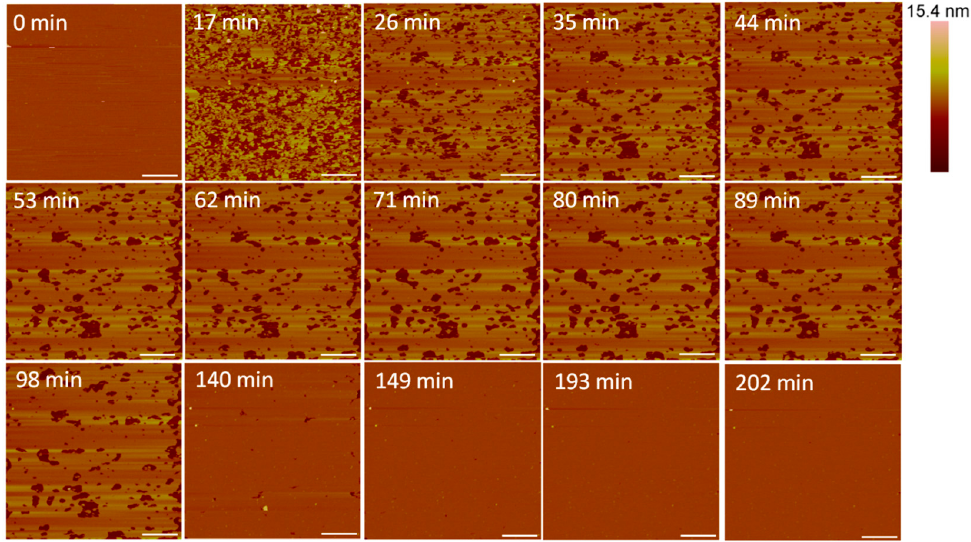
Figure 8 . Defects formed in a supported PC membrane after injection of 5 µM indolicidin. The scale bars represent a distance of 1 µm.